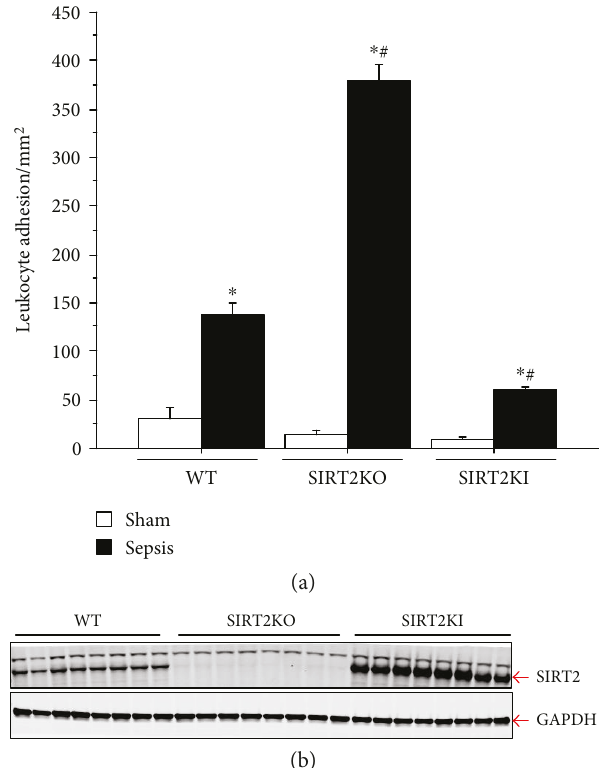
Figure 1: (a) Leukocyte adhesion with SIRT2 modi fi cation. Leukocyte adhesion in the small intestinal microcirculation in sepsis groups was signi fi cantly increased versus that in the respective sham groups ( n = 4 – 6 in each group). Leukocyte adhesion in SIRT2KO sepsis mice was signi fi cantly increased versus that in WT sepsis; leukocyte adhesion in SIRT2KI sepsis mice was signi fi cantly decreased versus that in WT sepsis mice. Leukocyte adhesion in SIRT2KI sepsis mice was signi fi cantly decreased versus that in SIRT2KO sepsis mice. Leukocyte adhesion in WT, SIRT2KO, and SIRT2KI sham mice were not signi fi cantly di ff erent from each other. ∗ p < 0 05 versus respective sham; # p < 0 05 versus WT sepsis using Tukey ’ s post hoc analysis; error bars: sem. (b) shows SIRT2 expression in peritoneal cells from WT, SIRT2KO, and SIRT2KI mice with CLP. As expected, SIRT2 expression in the peritoneal cell in SIRT2KO mice was signi fi cantly lower than that in WT while that in SIRT2KI mice was signi fi cantly higher compared to that in WT